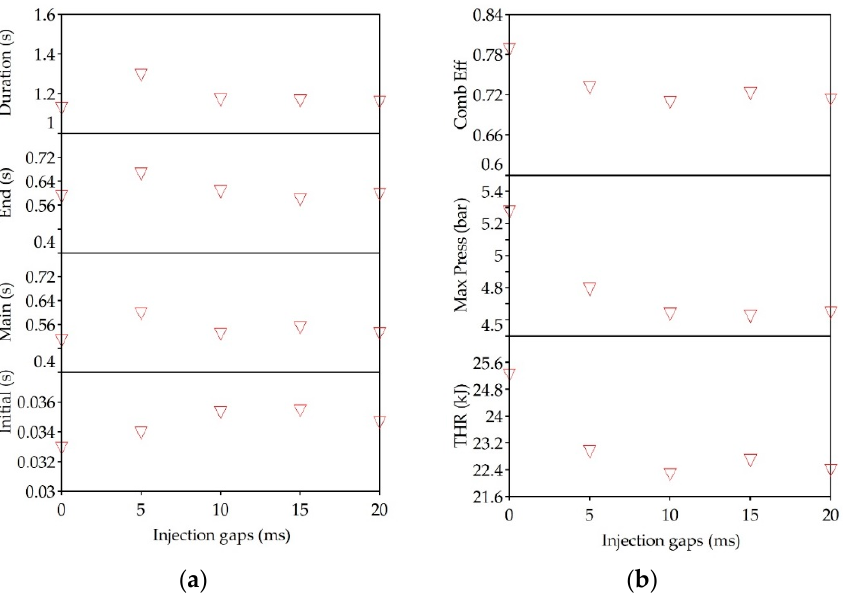
Figure 10. Combustion performance of diesel/CNG for various injection gaps for 70/30 Diesel/CNG